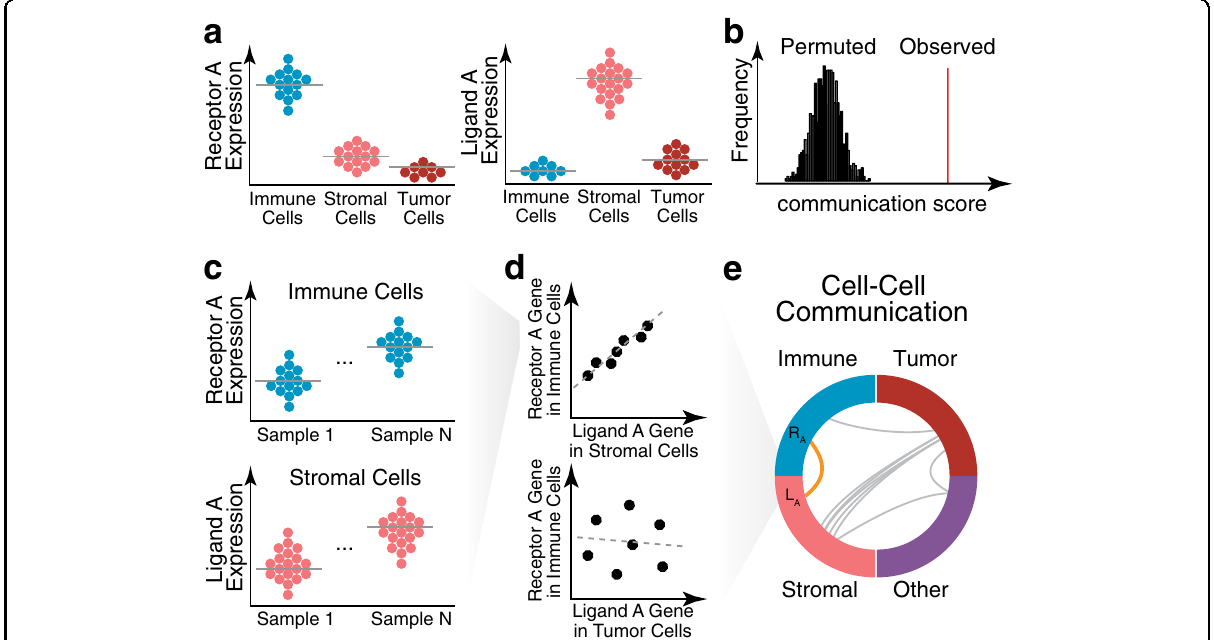
Fig. 5 Inference of cell – cell communication. a The codetection of receptor-ligand pairs may be used to identify putative cell-cell communication. In this illustration, the single-cell expression levels of known receptor-ligand pairs (Receptor A and Ligand A) are shown across cell types. High receptor expression is identi fi ed in immune cells, as illustrated in the beeswarm plot, where each point is a cell. Likewise, high ligand expression is identi fi ed in stromal cells. Such codetection may indicate putative cell – cell communication between these two cell types. b Codetection may be quanti fi ed as a cell – cell communication score that is evaluated through permutation testing to assess statistical signi fi cance. c When multiple samples are available, correlation between receptor-ligand pairs may be used to identify putative cell – cell communication. In this illustration, the single-cell expression levels of known receptor – ligand pairs (Receptor A and Ligand A) are again plotted for N samples. d (top) The average Receptor A gene expression in an immune cell type versus the average Ligand A gene expression in a stromal cell type shows a high correlation across samples (represented as points), indicative of cell – cell communication between these two cell types. (bottom) In contrast, the correlation of the average Receptor A gene expression versus the average Ligand A gene expression in immune and tumor cells shows a poor correlation across samples. e Such correlations may be indicative of cell – cell communication between immune and stromal cell types (orange). Such testing can be applied to all cell-type pairs and visualized as a circle